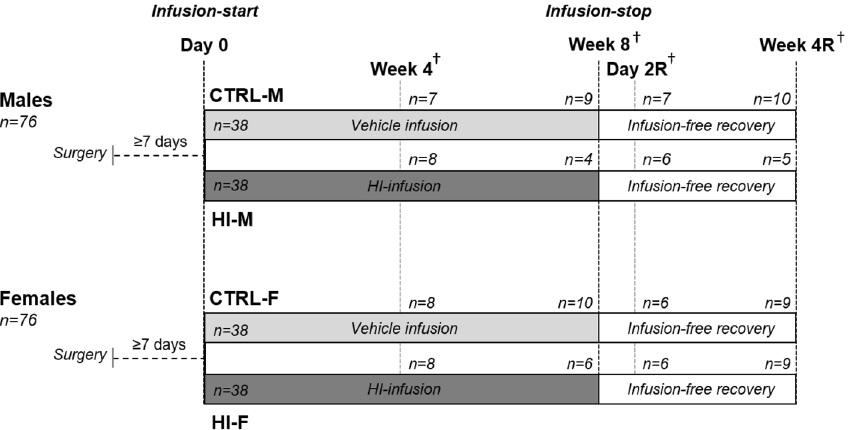
Figure 1. Study design. The study included male and female rats infused (surgically implanted intravenous catheter) with either vehicle or HI, resulting in a total of four groups: CTRL-M, HI-M, CTRL-F, and HI-F. Grey areas indicate the infusion period. Dark grey areas: Infusion with HI, light grey areas: Vehicle infusion. Infusion ended after 8 and was followed by an infusion-free recovery period. During infusion, animals were euthanized after 4 and 8 weeks. Following infusion-stop, animals were euthanized after 2 Days (Day 2R) or 4 weeks (Week 4R). † indicate euthanasia of animals. HI, human insulin; R,